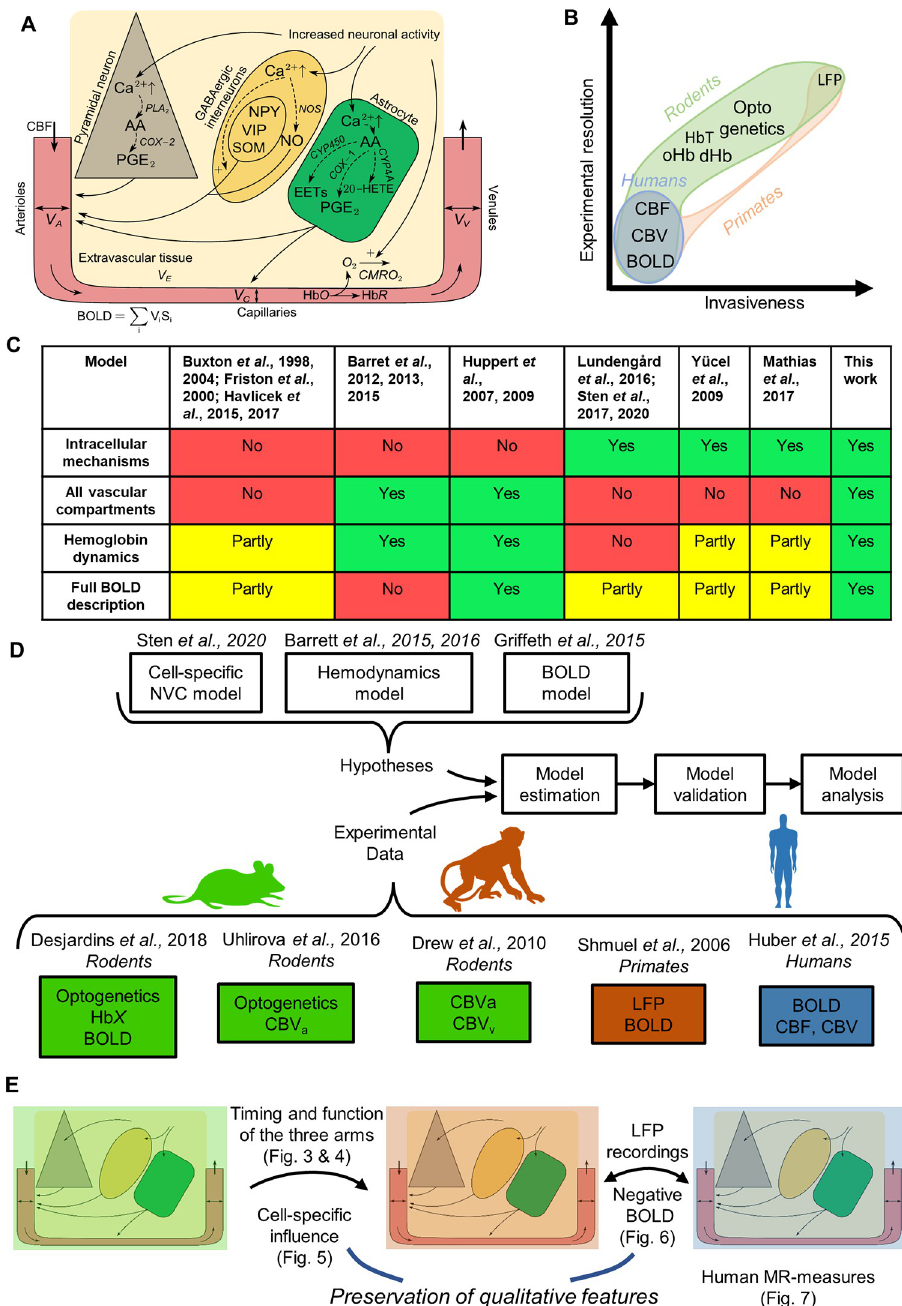
Fig 1. Overview of the presented study. A: Simplified schematic illustration of the cellular pathways underlying the NVC. Neuronal signaling activates GABAergic interneurons, pyramidal neurons, and astrocytes by stimulating the influx of Ca 2+ . Ca 2+ facilitates signaling pathways in the different cells. In GABAergic interneurons, Ca 2+ promotes nitric oxide (NO) through the upregulation of nitric oxide synthase (NOS). Furthermore, Ca 2+ also facilitates the release of different neuropeptides: neuropeptide Y (NPY), vasoactive intestinal peptide (VIP), and somatostatin (SOM). In pyramidal neurons, Ca 2+ promotes the synthesis of arachidonic acid (AA) via phospholipase A2 (PLA 2 ), which in turn is metabolized to prostaglandin E2 (PGE 2 ) via cyclooxygenase-2 (COX-2). In astrocytes, arachidonic acid is synthesized via phospholipase D2 (PLD 2 ) and subsequently metabolized into three different vasoactive molecules: PGE 2 via cyclooxygenase-1 (COX-1), epoxyeicosatrienoic acid (EET) via cytochrome P450 (CYP) epoxygenase, and 20-Hydroxyeicosatetraenoic acid (20-HETE) via CYP4A. Together these vasoactive messengers act on arterioles and capillaries to modulate the vessel diameters, where the neuronal messengers act primarily on the